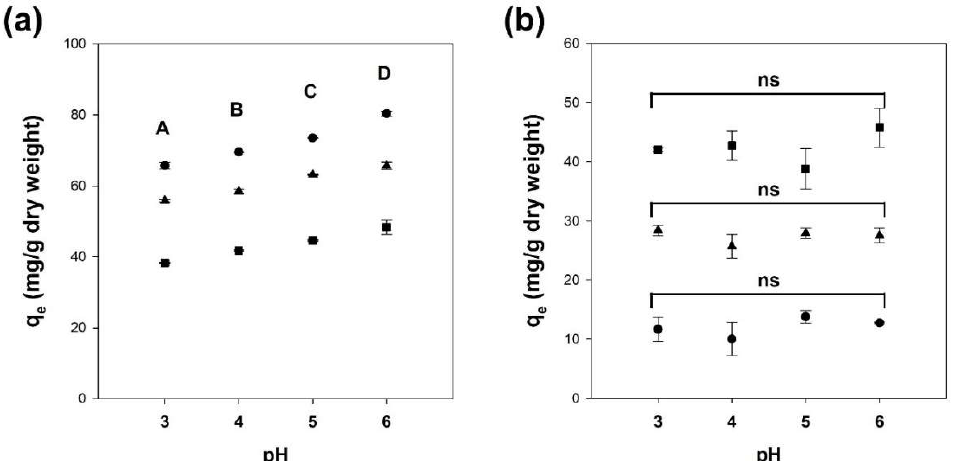
Figure 4. Effect of the initial solution pH on the adsorption of Cu 2+ ( a ) and benzene ( b ) onto alginate and alginate/biochar hydrogel beads (●: 4% alginate/0% biochar, ▲ : 4% alginate/1% biochar, ■ : 4% alginate/4% biochar). One-way ANOVA with Tukey’s test ( p < 0.05); ns: not significant, A, B, C, and D indicate group classified from Tukey’s test. The same letter means that there is no significant difference between the data.